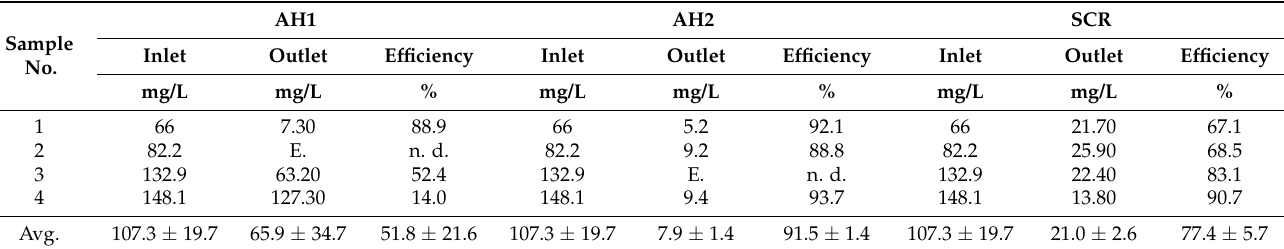
Table 9. Inlet and outlet TSS and removal efficiencies at stage